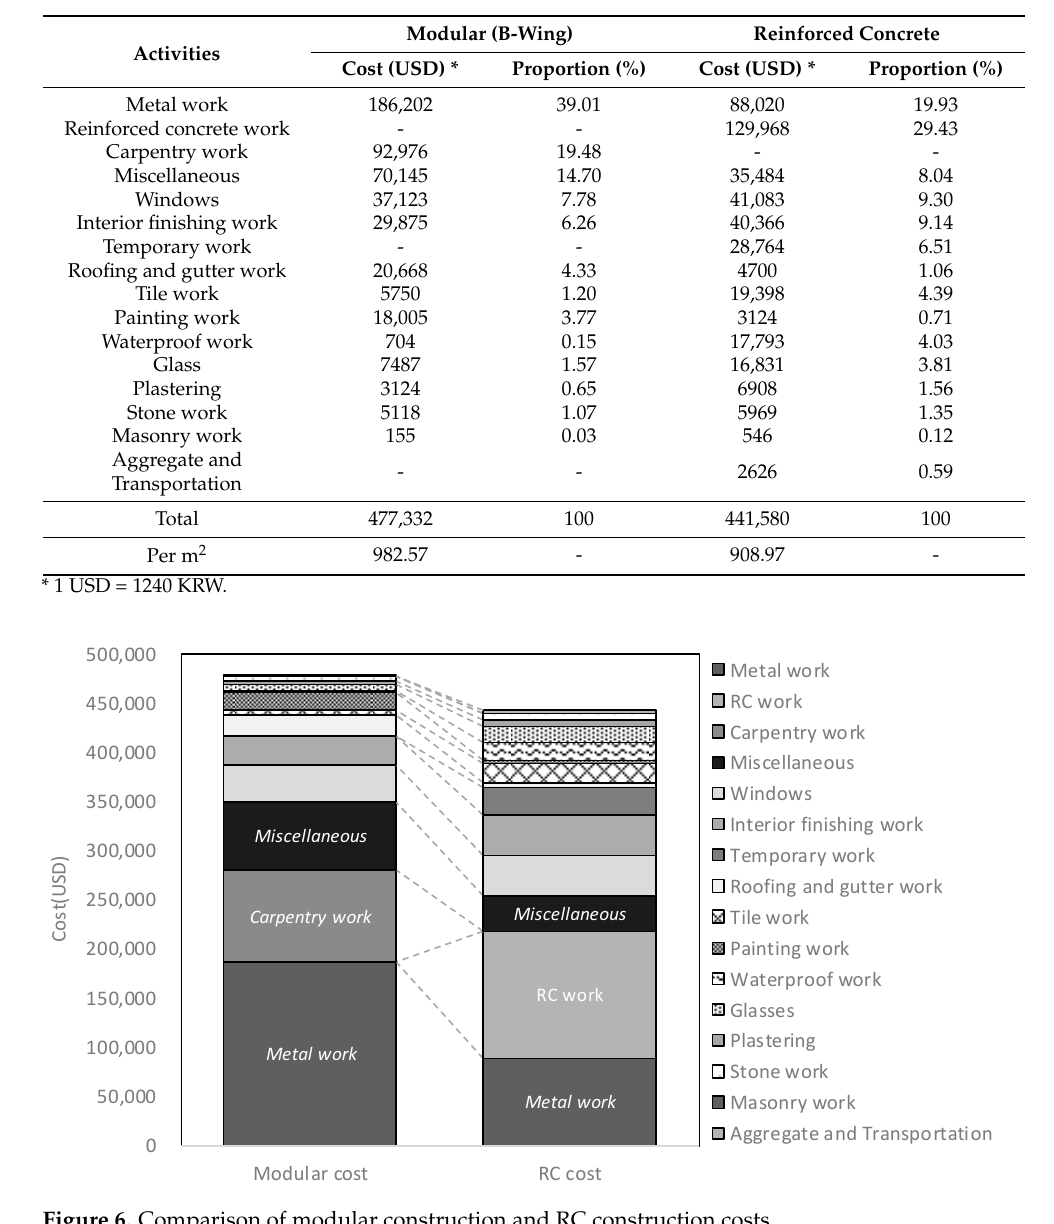
Figure 6. Comparison of modular construction and RC construction costs.